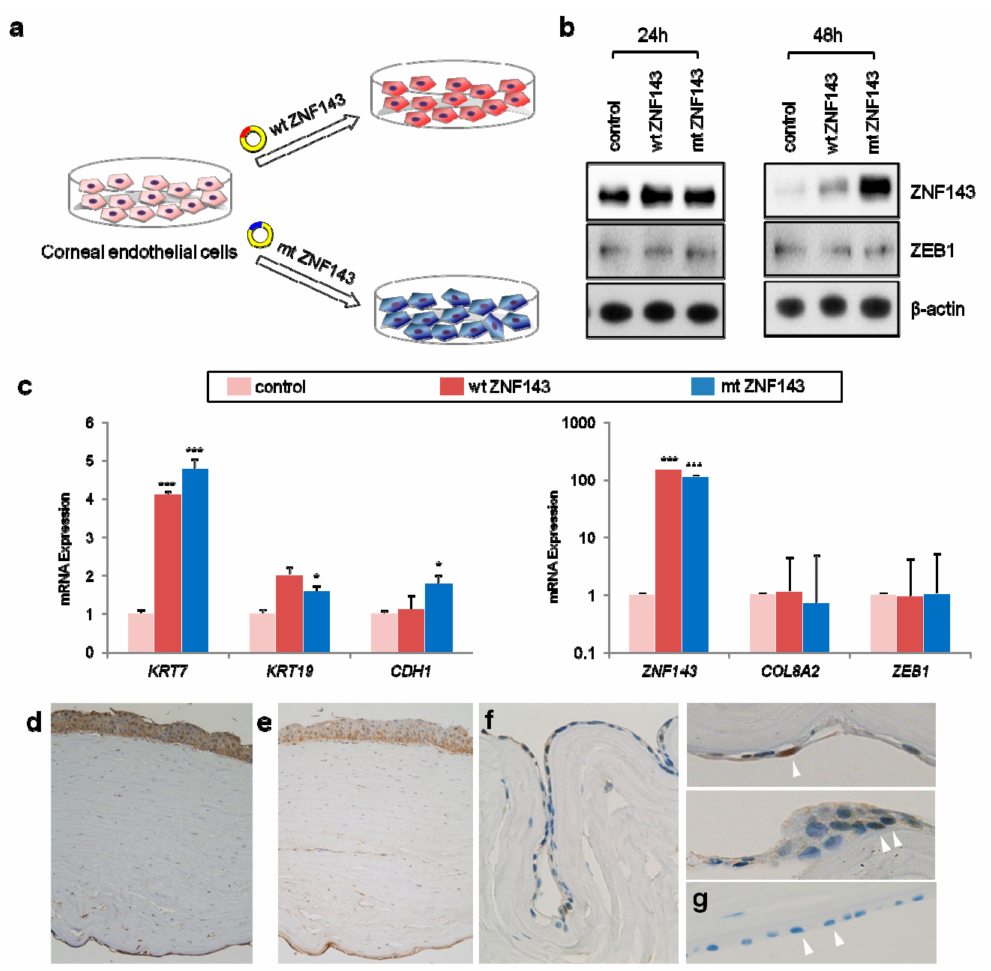
Figure 4. The e ff ect of wild-type (wt) ZNF143 and mutant ZNF143 p.Asp313His (mt) in human corneal endothelial cells (hCECs). ( a ) A schematic diagram to investigate the role of ZNF143 in hCECs. hCECs were transfected with plasmids encoding human wt or mt ZNF143 cDNA for 24–48 h and harvested for RT-qPCR and immunoblotting. ( b ) The expressions of ZNF143 and ZEB1 were verified by immunoblotting in hCECs transfected with wt or mt ZNF143 . Data shown are representative of at least three independent experiments. ( c ) The e ff ects of ZNF143 on various genes associated with corneal dystrophy and epithelialization were analyzed in hCECs transfected with wt or mt ZNF143 by RT-qPCR. COL8A2 and ZEB1 expression was not di ff erent in hCECs transfected with wt or mt ZNF143 compared to the control. Data are plotted by mean and standard deviation. OVOL2 is not expressed in hCECs used for this study. The expression of KRT7 , KRT19 , and CDH1 increased significantly in mt ZNF143 transfected hCECs. They reveal increased expression in wt ZNF143 -transfected cells with or without statistical significance. * p < 0.05, *** p < 0.001. Immunohistochemical staining revealed that ZEB1 ( d ) and COL8A2 ( e ) were positively stained both in corneal epithelium and endothelium. ZNF143 was expressed in cytoplasm and nucleus (arrow heads) of patient CECs ( f ) while it was not expressed in control CECs ( g